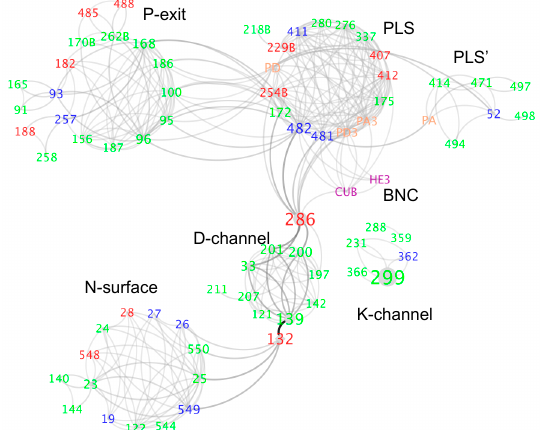
Figure 4. Hydrogen bond network in Rb. sphaeroides CcO [119]. The network is divided into circular clusters with well-connected residues shown as: N-surface, D-channel, K-channel, BNC, PLS, PLS’, P-exit. Residues are shown as individual nodes, labeled by residue number, followed by B to identify residues in subunit II. Heme a 3 is labeled as HE3, while Cu B as CUB, propionic acids of heme a 3 as PA3/PD3, propionic acids of heme a as PA/PD. The labels are colored based on amino acid type; red: acid; blue: base; green: neutral polar; orange: propionic acid; purple: BNC. The larger nodes and darker edges show more important connections in the network